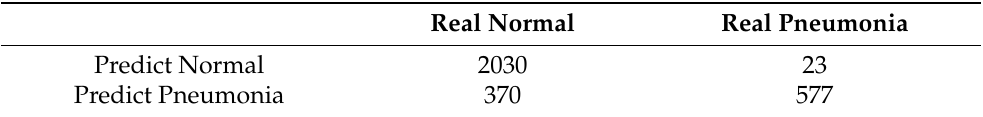
Table 16. Confusion matrix of SDViT on the synthetic-covid-cxr